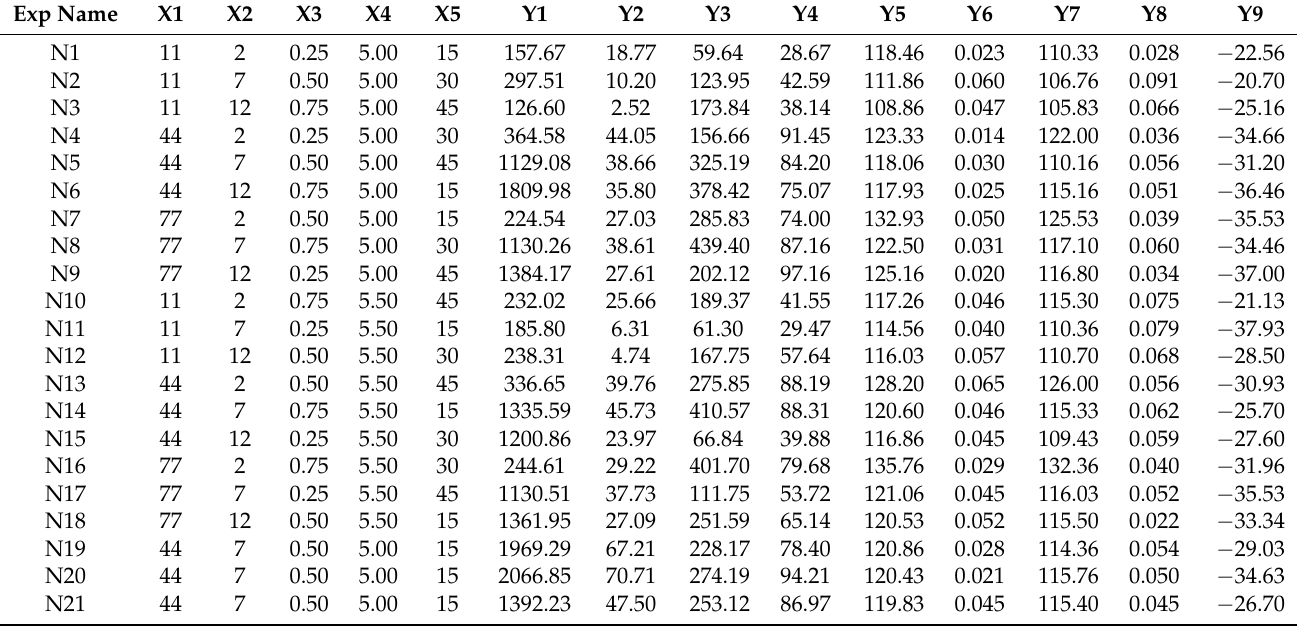
Table 4. Fractional factorial experimental design and